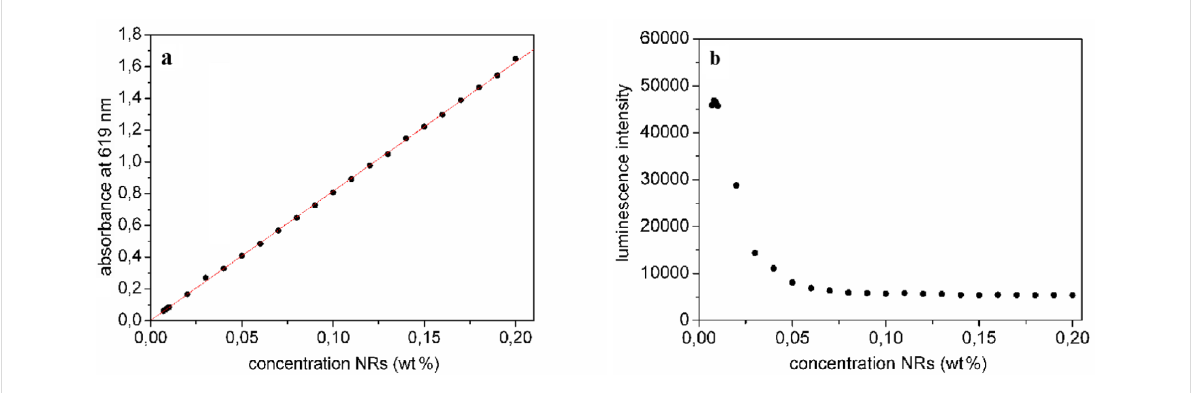
Figure 2: a) Absorption intensity of the first exciton peak (619 nm), b) luminescence intensity of the emission maxima (632 nm) as a function of concentration in chloroform solution for bullet shaped NRs (aspect ratio 3).